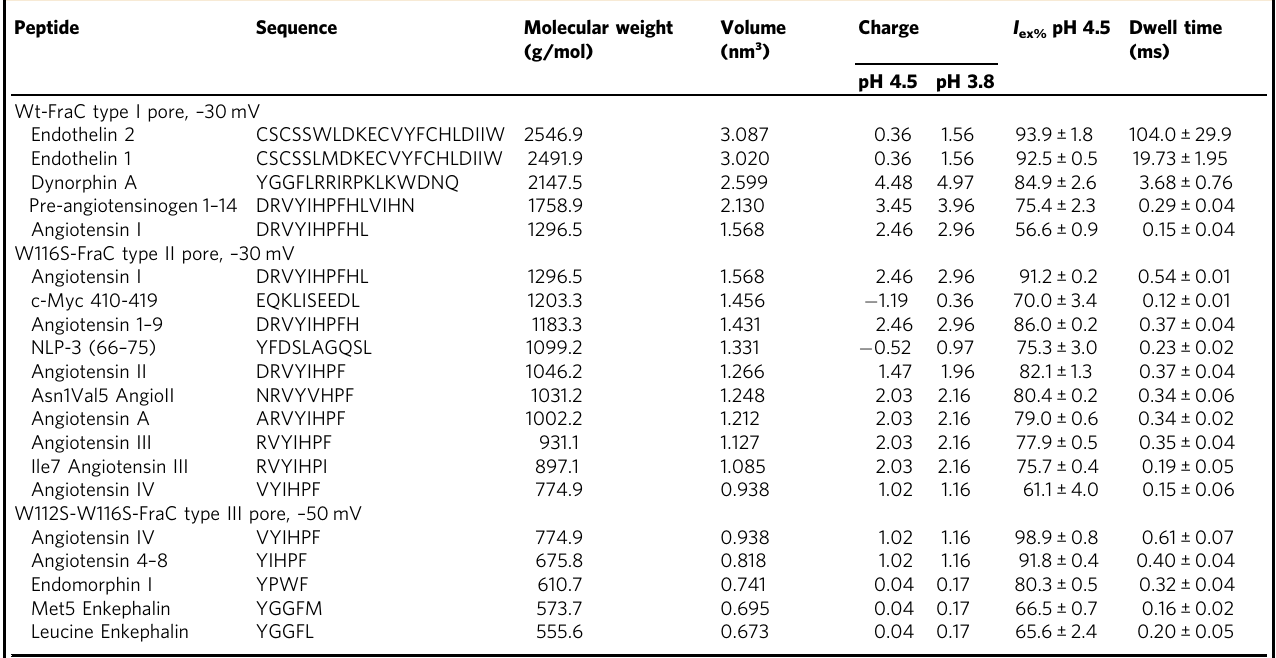
Table. 1 Peptide analysis with different types of FraC nanopores at pH 4.5